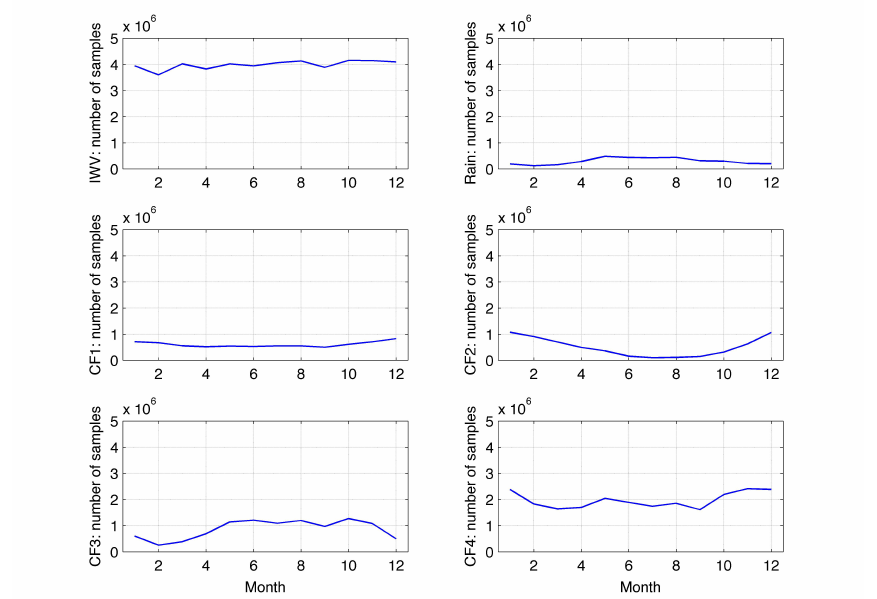
Figure 1. Number of samples of integrated water vapour (IWV), rain (ILW ≥ 400 g/m 2 ) and cloud fraction (CF) of four cloud categories (defined in the text) as a function of month observed by the TROWARA radiometer in Bern from 2004 to 2016.